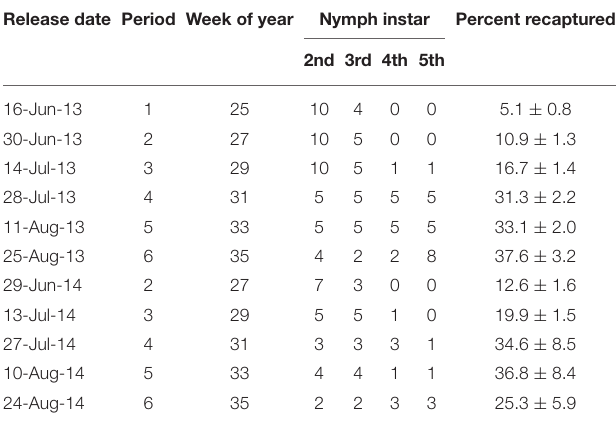
TABLE 1 | Release dates, abundance, and percent recaptured of marked H. halys nymphs and their life stage (instar) released per